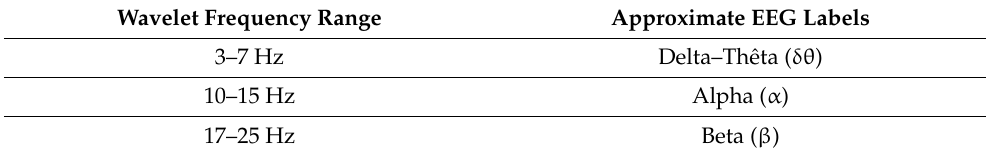
Table 2. Correspondence between wavelet frequency range and standard EEG frequency band